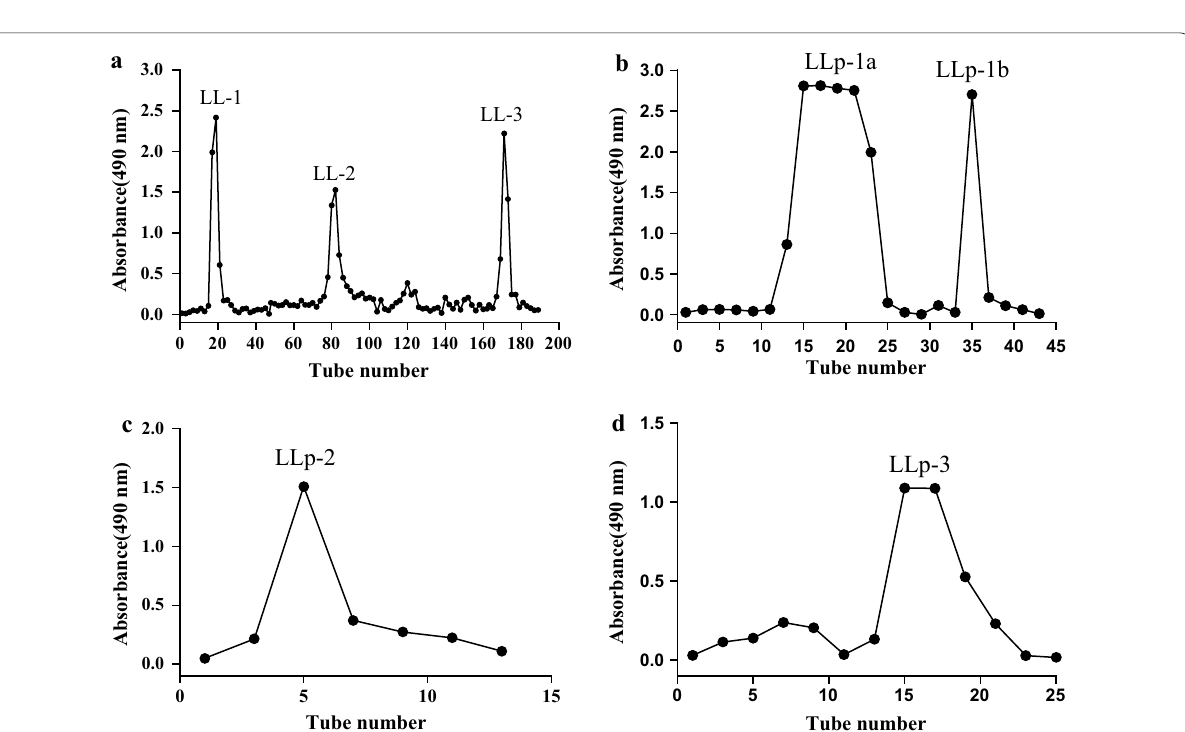
Fig. 1 Elution curve of crude polysaccharide by DEAE-52 cellulose column chromatography ( a ), elution curve of LL-1 on Sephadex G-100 column ( b ), elution curve of LL-2 on Sephadex G-100 column ( c ), elution curve of LL-3 on Sephadex G-100 column ( d )